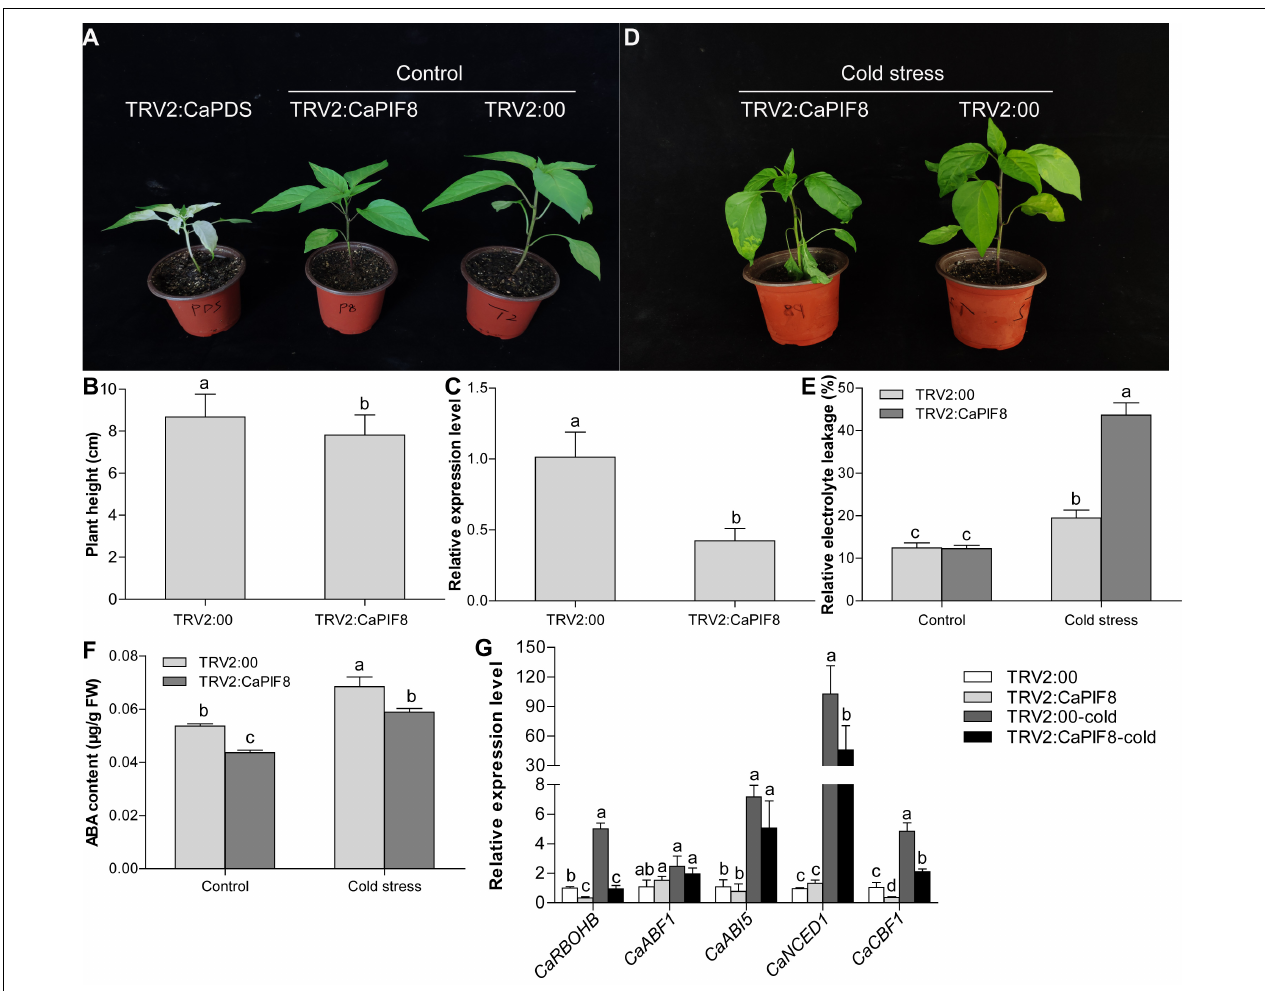
FIGURE 7 | Effect of CaPIF8 silencing on the cold stress tolerance of pepper. (A) Phenotypes of pepper plants after approximately 1 month of virus injection. TRV2:CaPDS, plants with the TRV2:CaPDS vector; TRV2:CaPIF8, CaPIF8 -silenced plants; TRV2:00, control plants with the empty TRV2 vector. (B) Height of TRV2:00 and TRV2:CaPIF8 pepper plants before cold stress. (C) Relative expression of CaPIF8 in leaves from CaPIF8 -scilenced and control pepper plants. Leaf samples from TRV2:00 and TRV2:CaPIF8 plants were collected before cold stress. (D) Phenotypes of TRV2:00 and TRV2:CaPIF8 plants after 4 ◦ C cold stress for 3 days. (E) REL of TRV2:00 and TRV2:CaPIF8 plants. Leaf samples from TRV2:00 and TRV2:CaPIF8 plants were collected without and with cold stress for 3 days. (F) ABA content of TRV2:00 and TRV2:CaPIF8 plants. Leaf samples from TRV2:00 and TRV2:CaPIF8 plants were collected without and with cold stress for 12 h. (G) Relative expression levels of stress-related genes examined by qRT-PCR in leaves from TRV2:00 and TRV2:CaPIF8 plants without and with cold stress for 6 h. Each value is shown as mean ± standard error of three biological replicates, and the multiple comparison test for each gene was presented. Different letters